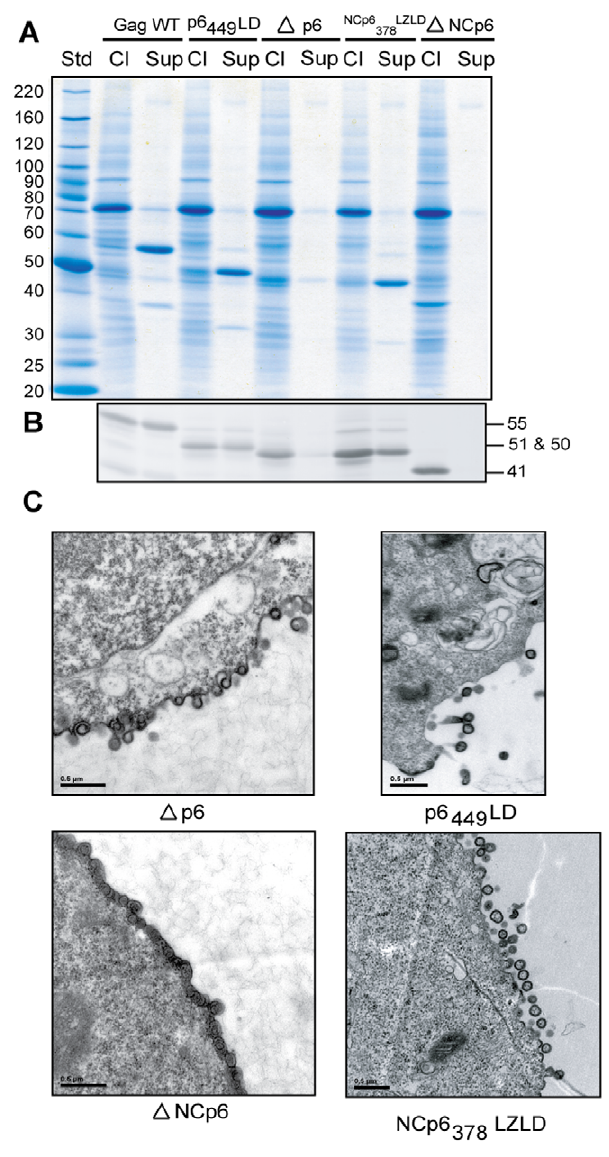
Figure 7. Domains NC and p6 are required for VLP release, although they can be replaced with heterologous hCREB and p2b sequences. (A) 293T cells were transfected either with Gag WT or expression vectors encoding for NC or P6 mutants (i.e. D p6, D NCp6, p6 449 LD and NCp6 378 LZLD). At 48 h post-transfection, cell lysates and cell-free supernatants were analyzed on gradient SDS-PAGE and protein stained with Coomassie Brilliant Blue. (B) In parallel, an IP assay was performed using the anti-p24 antibody on the same samples. Precipitated proteins were run on SDS-PAGE and Gag proteins were analyzed by WB. (C) Transfected 293T cells were analyzed by TEM (magnification: 6 50,000). The Biochemical experiments shown are representative of at least three independent experiments and two for the microphotographs.